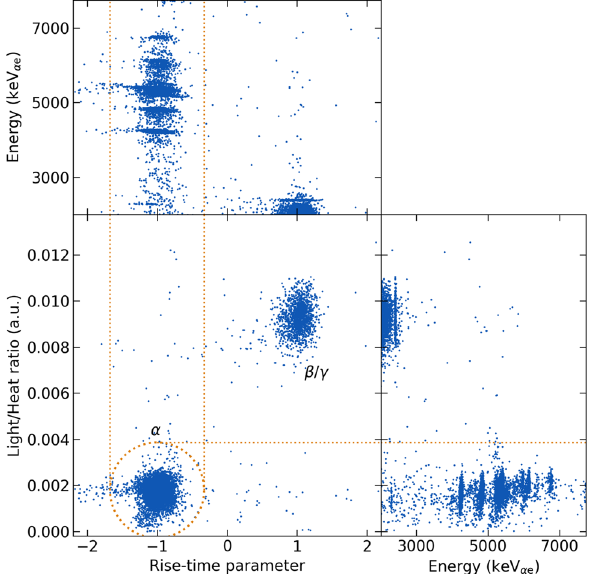
Fig. 2 The α -event selection requirements based on the rise time parameter and light/heat ratio for C4. The rise-time is normalized for β/γ and α to be aligned at 1 and -1, respectively. Events in the ellipse in the bottom-left are the selected α -events. The slope of the Light/Heat ratio on energy in the right-hand side panel is due to the energy depen- dence of quenching of the scintillation light output for alpha parti- cles [29]